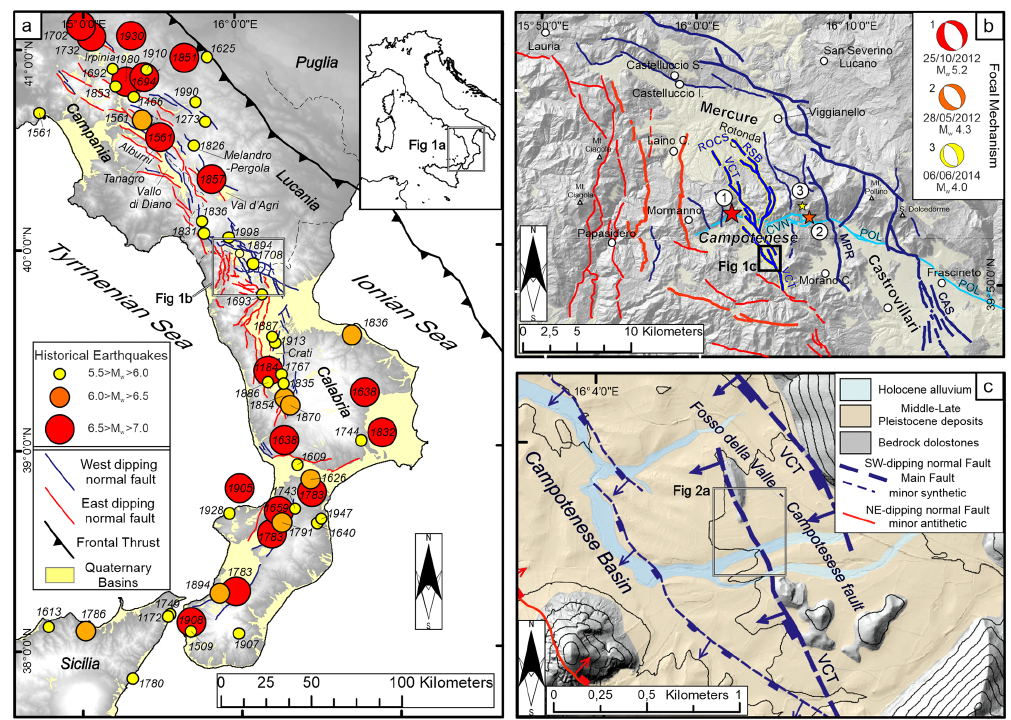
Figure 1. Location maps of the study site (DTM sources: TINITALY by Tarquini et al., 2012, and by Regione Calabria – http://geoportale. regione.calabria.it/opendata, last access: 11 June 2021, under license IODL 2.0. – https://www.dati.gov.it/iodl/2.0/, last access: 11 June 2021): (a) image illustrating the southern Italian peninsula with the regional faults pattern and the historical strong earthquakes (Rovida et al., 2020); (b) map showing the studied region with local faults (modified after Brozzetti et al., 2017a), and epicenters (stars) and focal mechanisms of the mainshocks of the 2012–2014 seismic activity (Scognamiglio et al., 2006); (c) location of the GPR survey area within the Campotenese Quaternary basin crossing the Fosso della Valle–Campotenese (VCT)